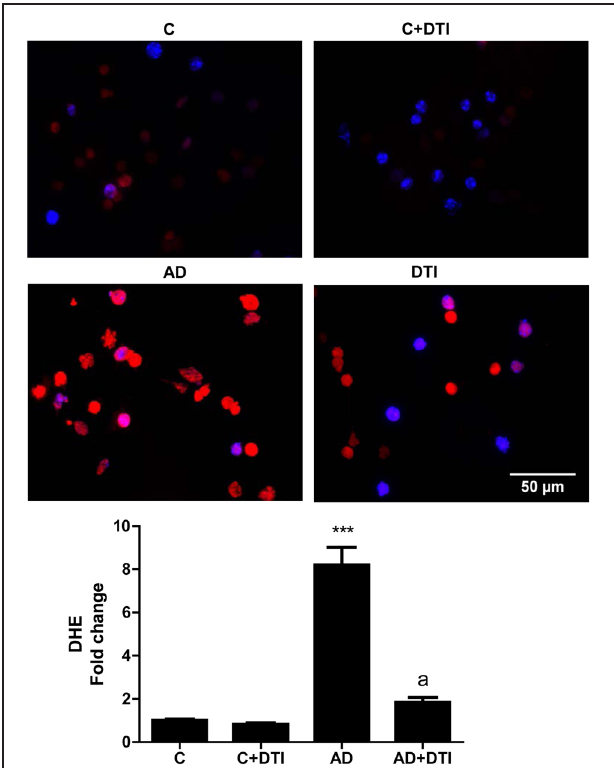
FIGURE 4 | Brain tissue sections from frontal cortices from control, control + DTI, AD, and AD + DTI mice were incubated for 30min with 5 μ M of Dihydroethidium (DHE, red) fluorescence dye, and NucBlue stain (blue). Data represents signal intensities of DHE stained cells to non-stained cells. ∗∗∗ p < 0 . 001 vs. control (C); a p < 0 . 001 vs. AD.